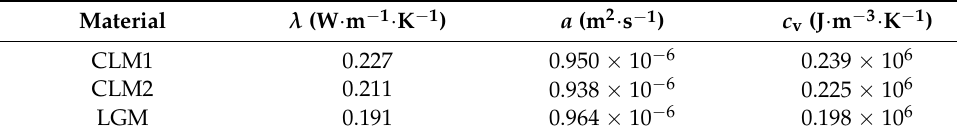
Table 6. The thermal properties of the hardened plasters.